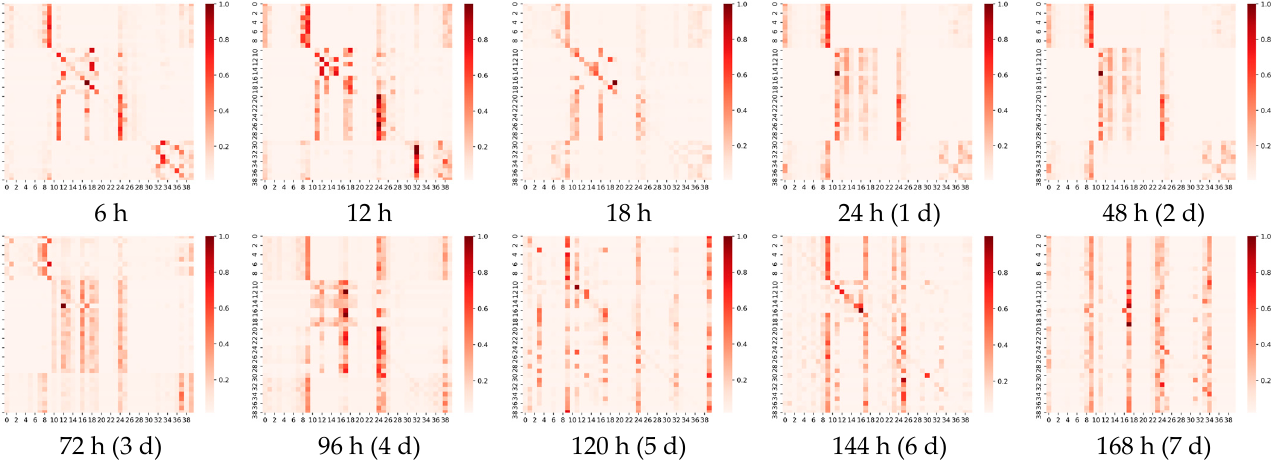
Figure A2. The learned graph structure (40 nodes) at different prediction scales, in order, 6 h, 12 h, 18 h, 24 h (1 d), 48 h (2 d), 72 h (3 d), 96 h (4 d), 120 h (5 d), 144 h (6 d), and 168 h (7 d).